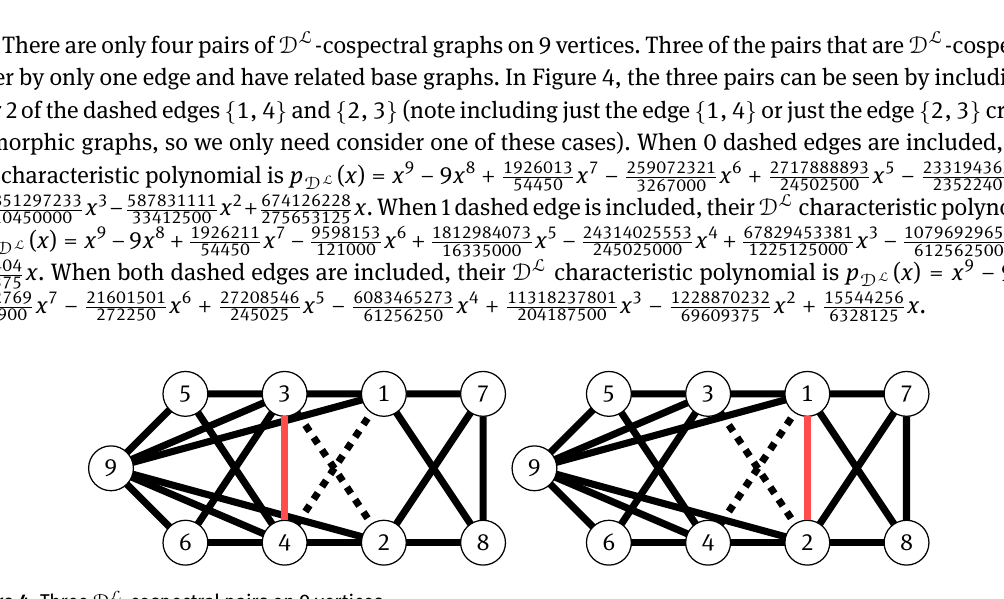
Figure 3: Graphs that are D L but not D L -cospectral using the co-transmission twins construction